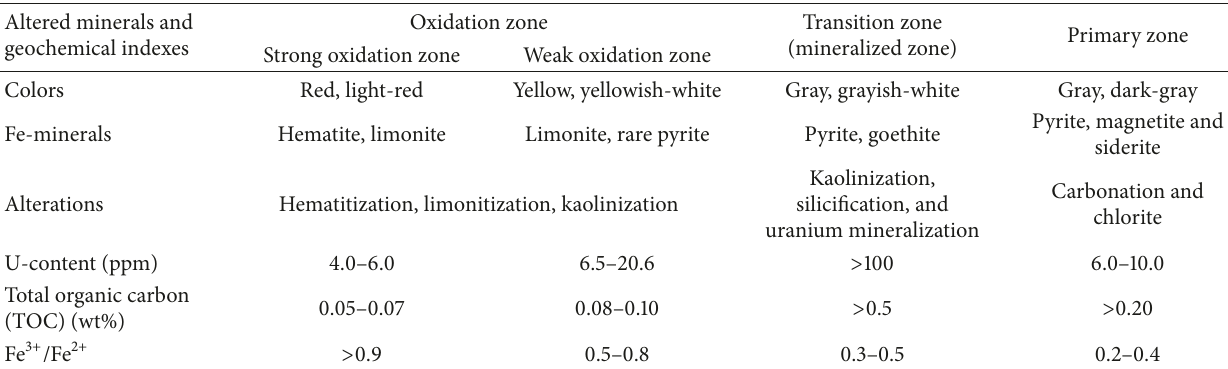
Table 1: Altered minerals and geochemical indexes of each geochemical zone in the Mengqiguer uranium